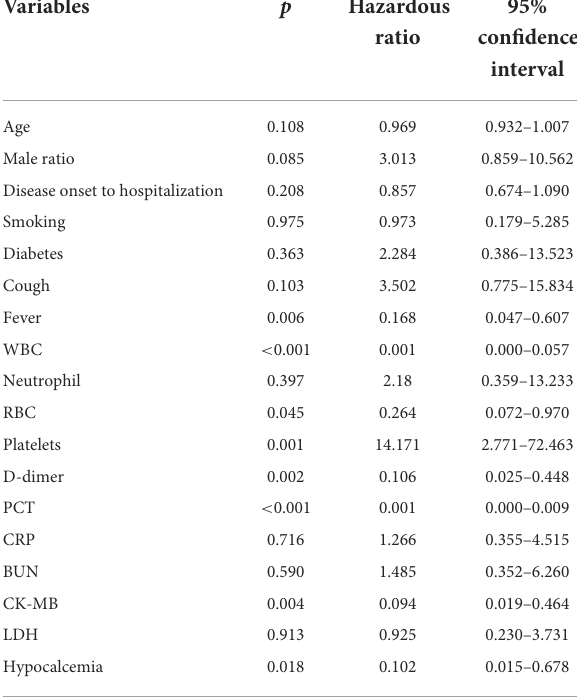
TABLE 4 Variables ( p < 0.05) with clinical relevance were performed using multivariate logistic regression analysis to explore the independent risk factors associated with differences between the influenza cohort and the COVID-19 1